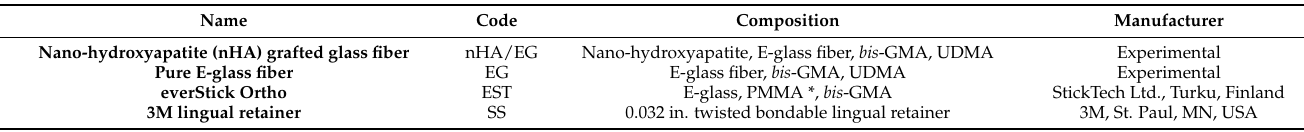
Table 1. Description of control and experimental